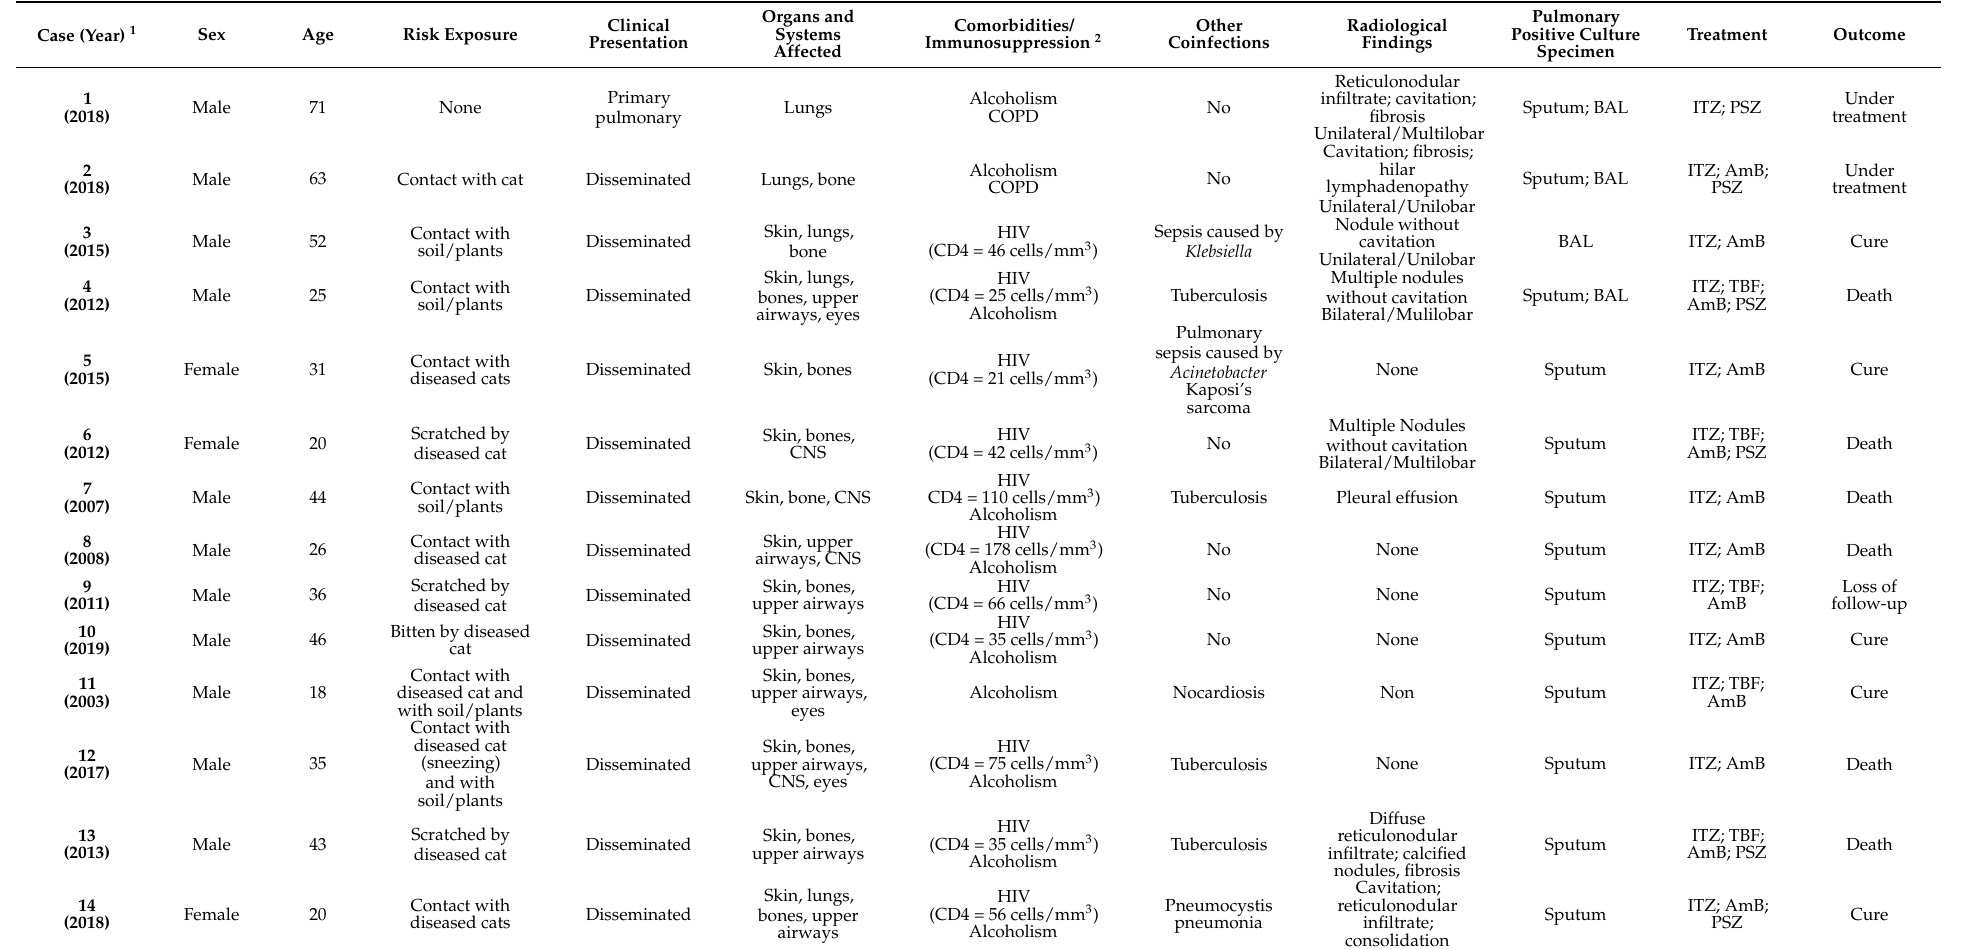
Table 1. Clinical data of patients with positive cultures from pulmonary specimens at the Evandro Chagas National Institute of Infectious Diseases, from 1998 through